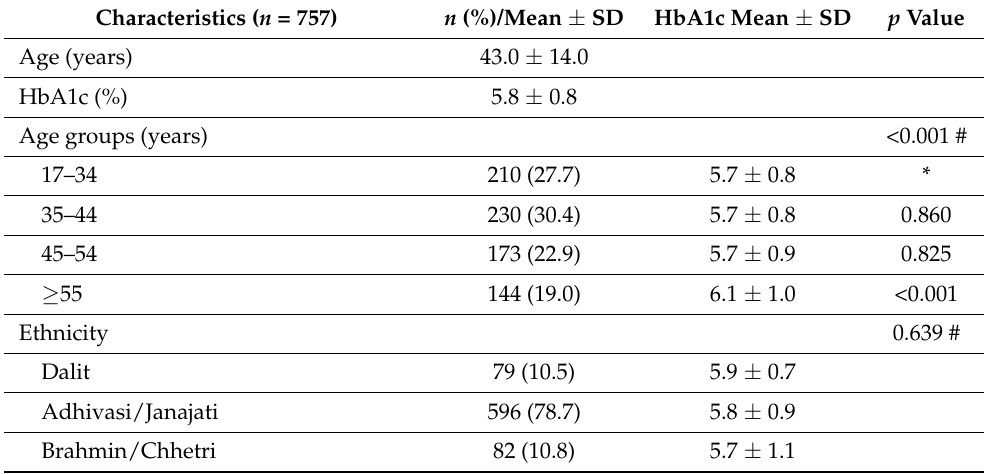
Table 1. Sociodemographic and lifestyle factors by glycated hemoglobin (HbA1c) level of the study